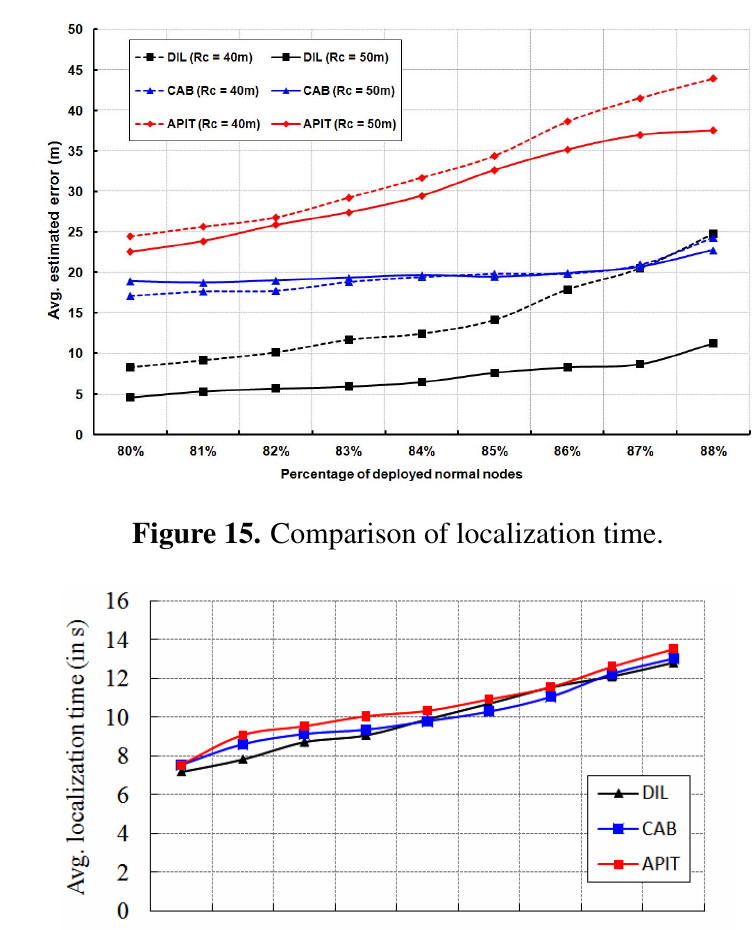
Figure 14. Comparison of average estimated localization error for different number of beacon nodes.